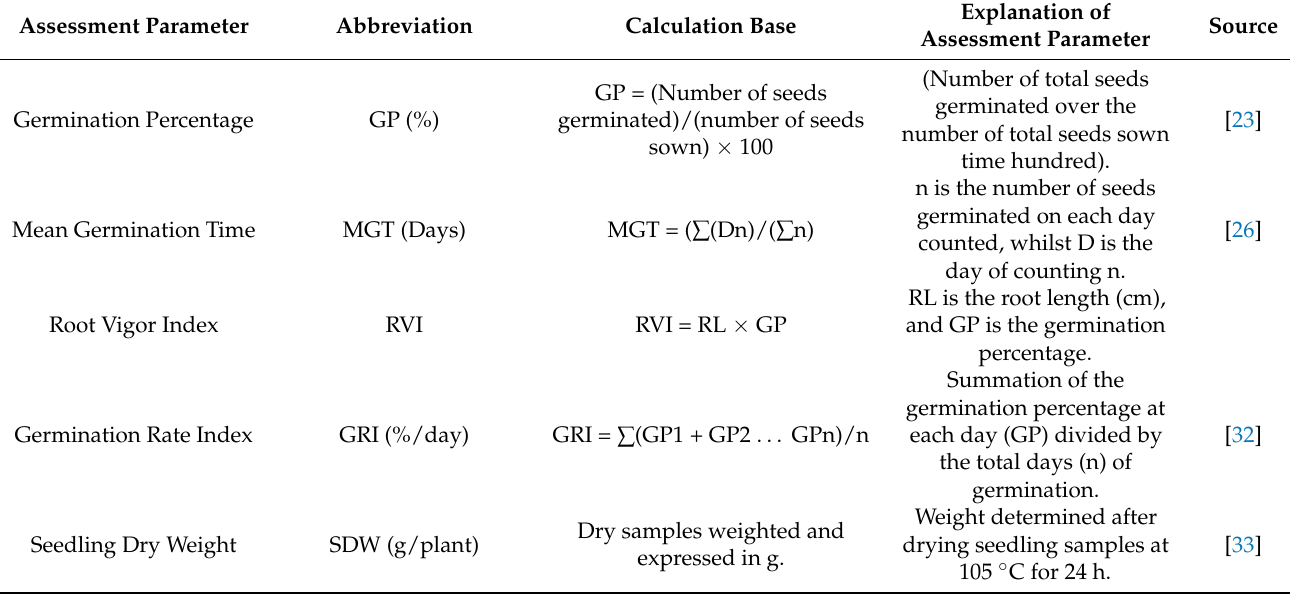
Table 3. Seed germination assessment